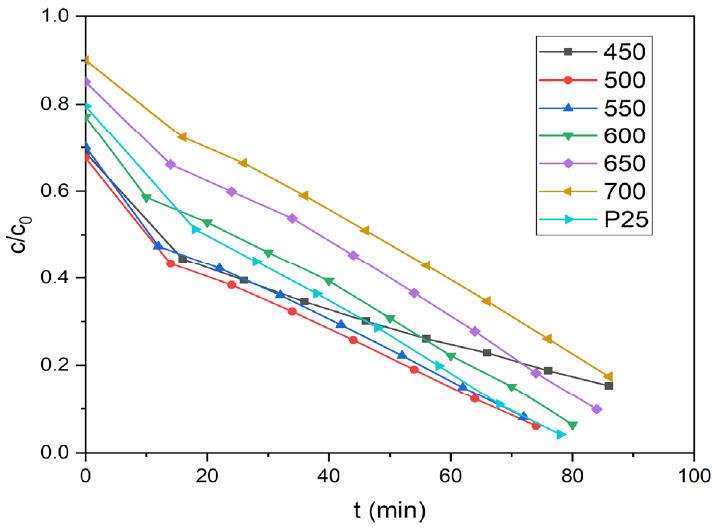
Figure 6. Photocatalytic degradation of PB with sample A calcined at different temperatures